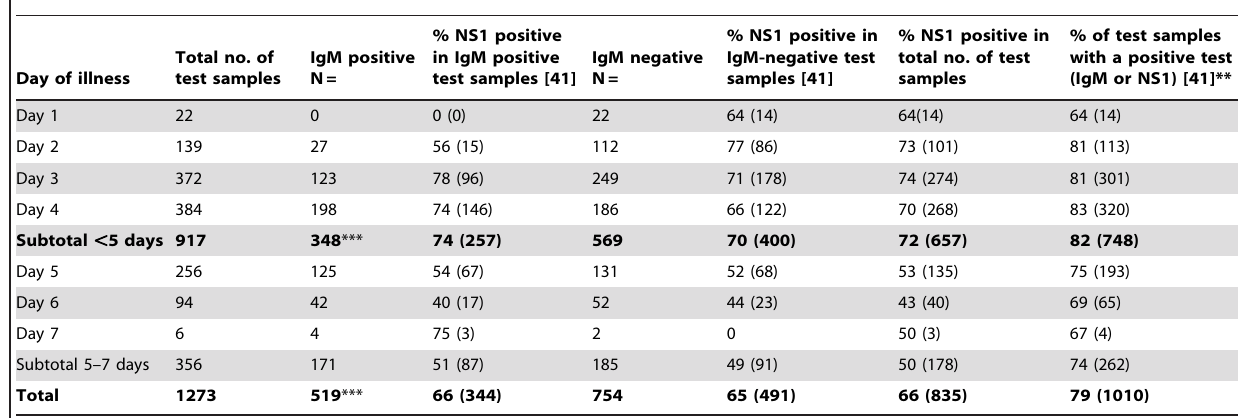
Table 5. NS1 detection (kit Platelia assay only) in relation to IgM status and day of illness.*